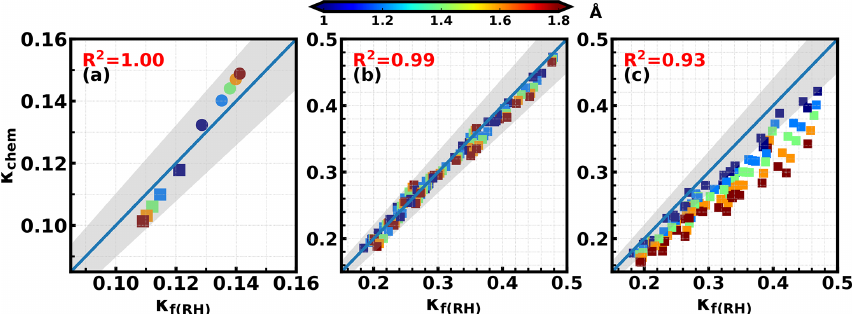
Figure 4. κ chem versus κ f( RH ) ; colors represent average Ångström exponent ( Å ) values of corresponding PNSD (a) corresponding to size- resolved κ D distributions shown in Fig. 3 (squares correspond to the solid line in Fig. 3, and circles correspond to the dashed line in Fig. 3). p (b) and (c) correspond to size-resolved κ D distributions shown in Fig. S4 for PM 1 and PM 10 , respectively. Gray areas represent the absolute p relative differences between κ chem and κ f( RH ) less than 10%. Table 3. Average (range) mass contribution of ammonium, nitrate, sulfate, and organics to NR-PM 2 . 5 and NR-PM 1 during different periods. Species Ammonium Nitrate Sulfate Organics PM 1 PM 2 . 5 PM 2 .